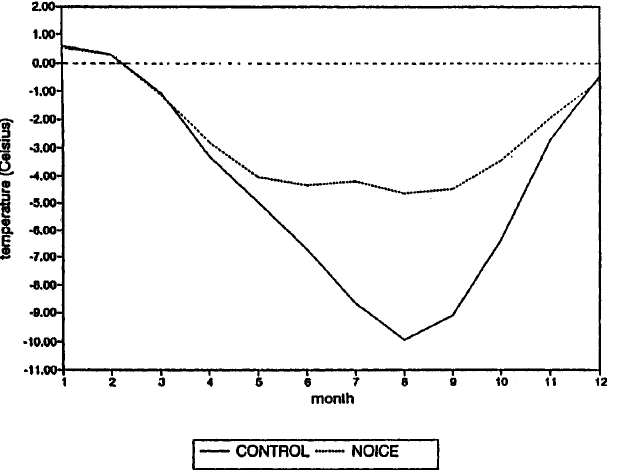
Fig. 4. Mean seasonal variation of the temperature in the model’s lowest sigma level, averaged between 55 (cid:176) S and 70 (cid:176) S, in (cid:176) C